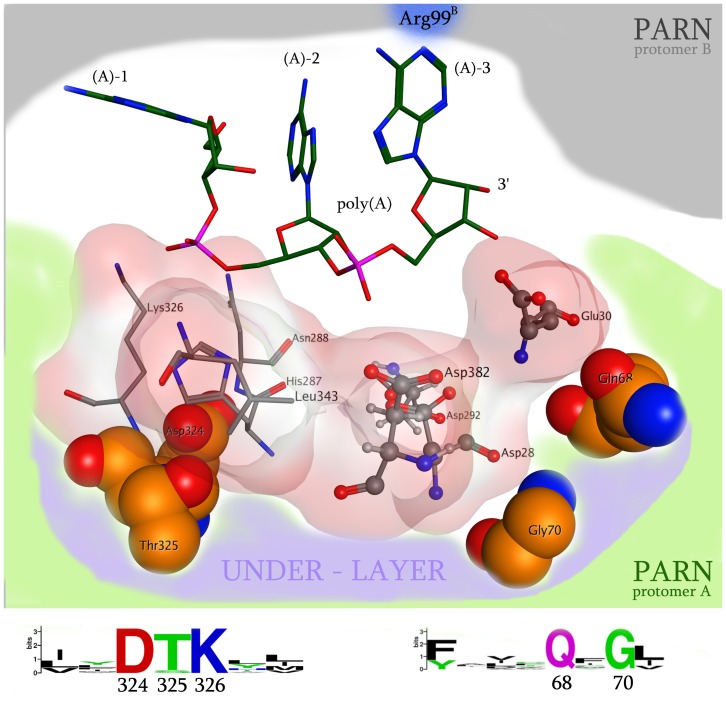
A representation of the 3D organization of the catalytic site of PARN.The RNA interacting and structurally conserved residues (Asp324, Thr325, Gly70, Gln68, Leu343, Asn288, Lys326) are shown in an electrostatic cloud, whereas the four evolutionary invariant amino acids that conformationally support the catalytic residues are shown in specefill representation (labeled as under-layer, Asp324, Thr325, Gln68, Gly70). The invariant residues that were detected in the PARN protein motifs by our phylogenetic analysis are showing below the 3D structure.